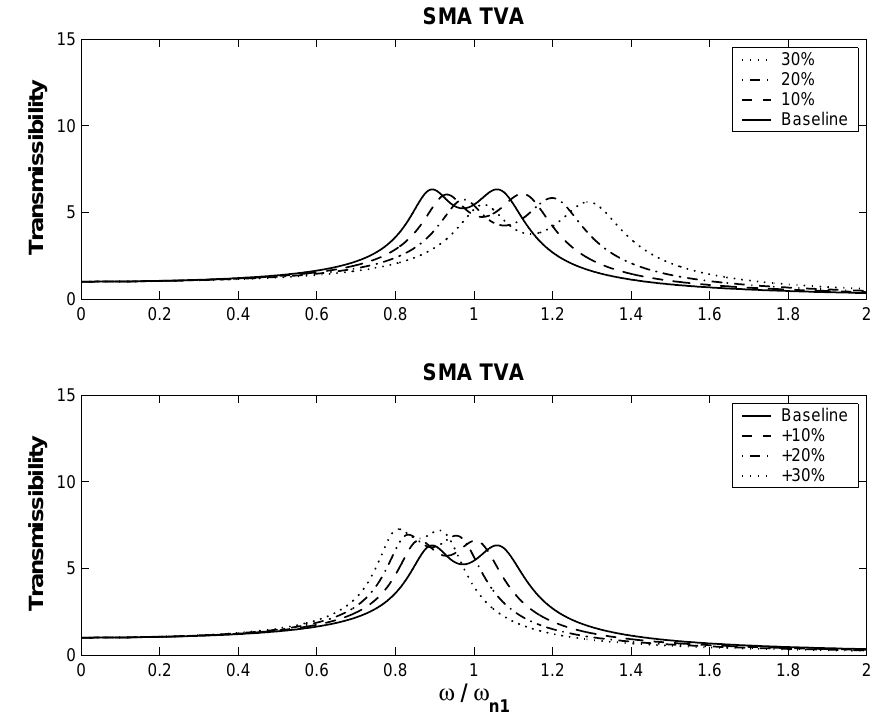
Fig. 7. Peak transmissibility variation of the SMA TVA: (a) decreasing the primary mass (b) increasing the primary mass. where σ , ε , l 0 , A , and ∆ x are the stress, strain, initial length, cross section area, and deflection of the SMA wire, respectively. Also, E is the Young’s modulus and subscripts A and M indicate the austenite and martensite phases respectively; where E A > E M . This way, the stiffness of the wire is a function ξ ; this stiffness, as illustrated in Fig. 5, is maximum when the wire is in the austenite phase ( ξ = 0 and E = E A ). Likewise, the minimum stiffness is obtained when the wire is in the martensite phase ( ξ = 1 and E = E M ). When 0 < ξ < 1 , the instantaneous stiffness of the SMA wire is between the two extreme